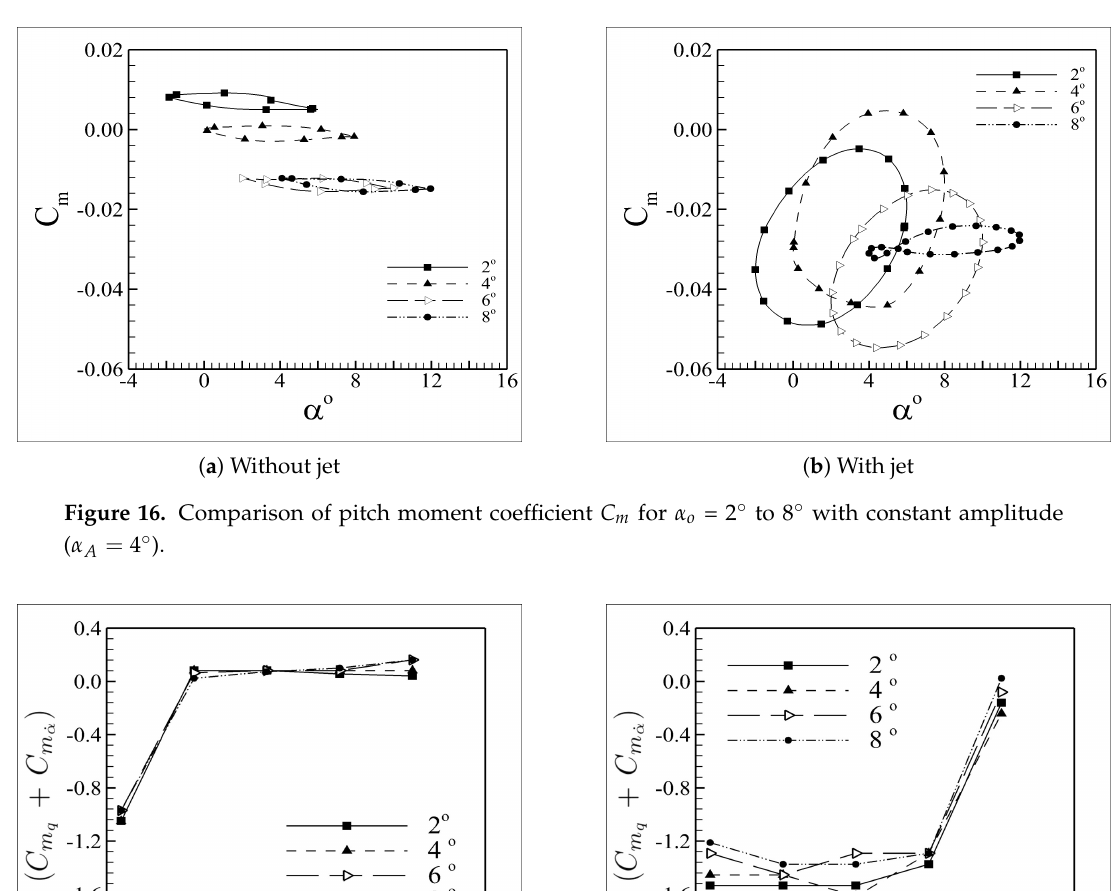
+ C m ) airfoil with constant q ˙ α